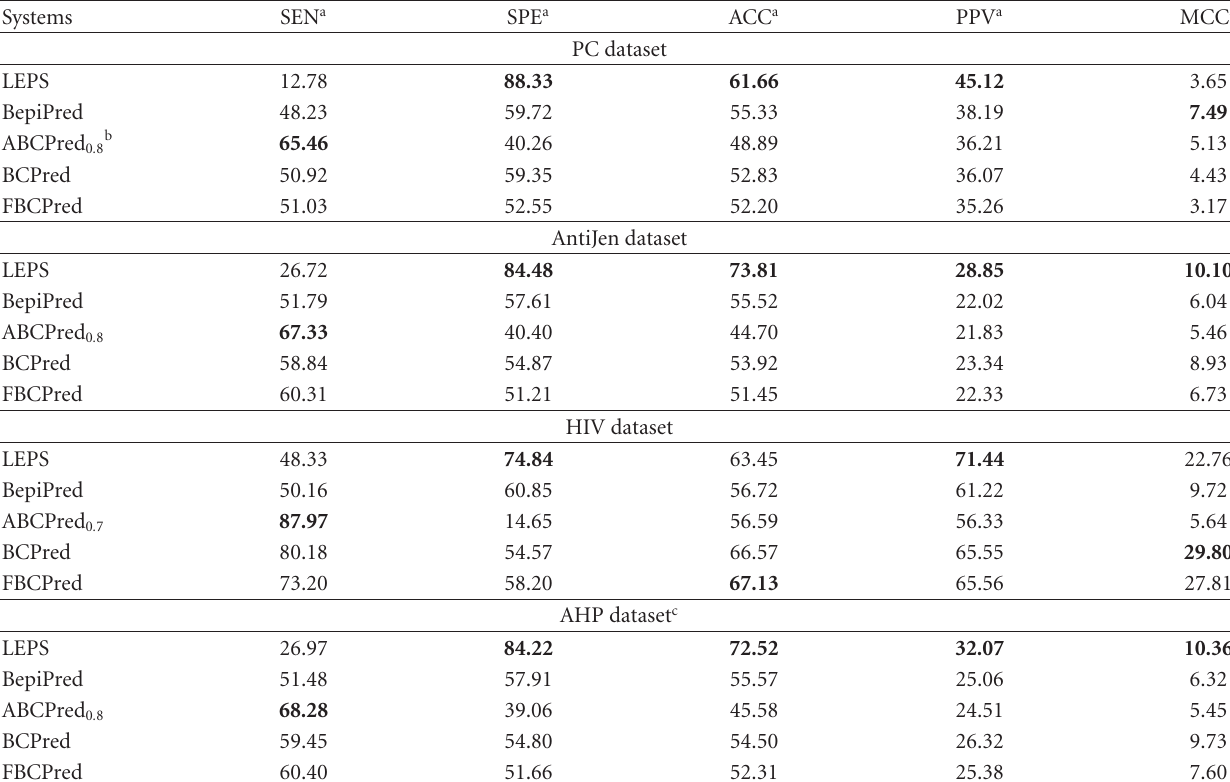
Table 2: Comparison of the performances of LEPS, BepiPred, ABCPred, BCPred, and FBCPred systems.